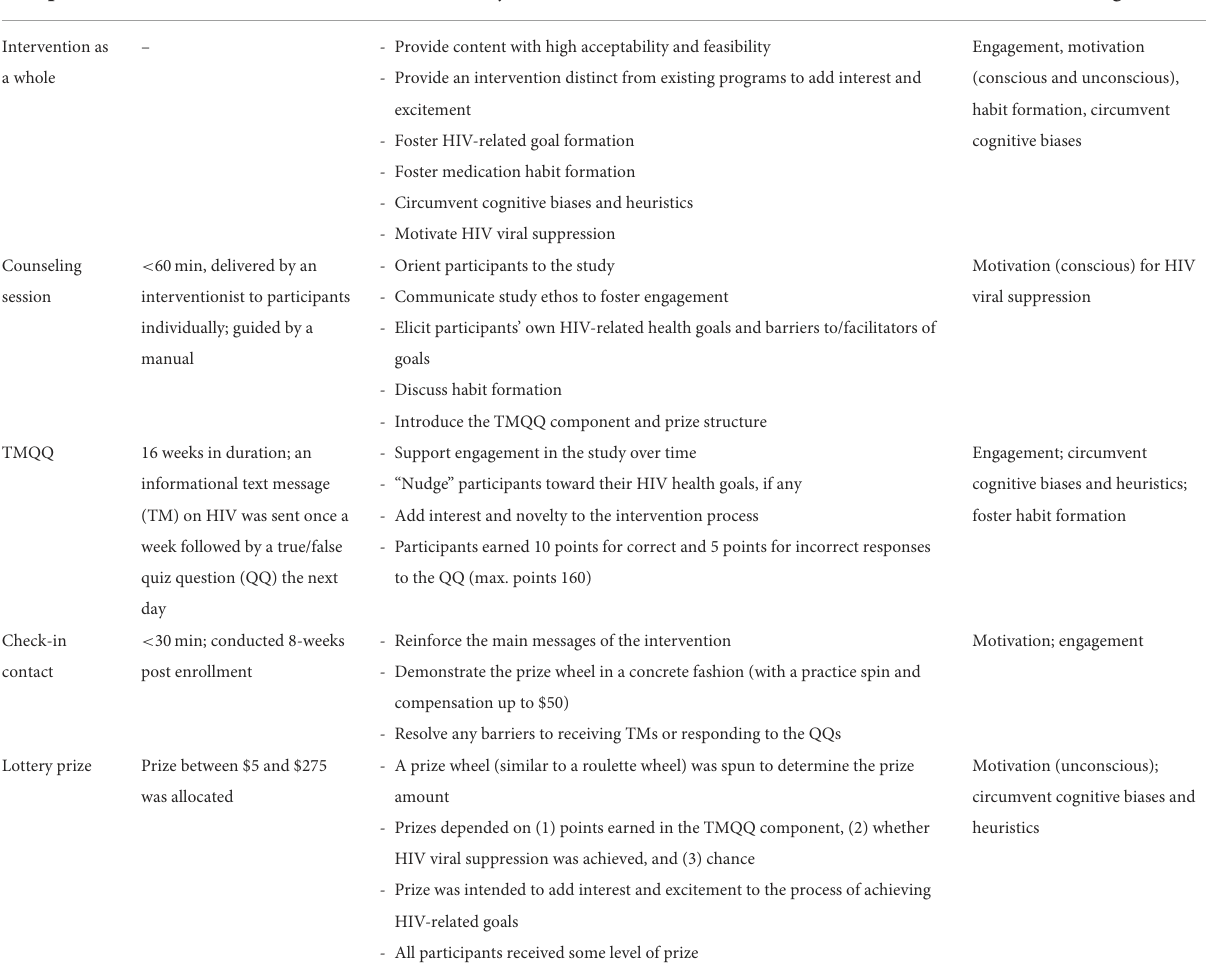
TABLE 1 Description of the components that make up the SCAP